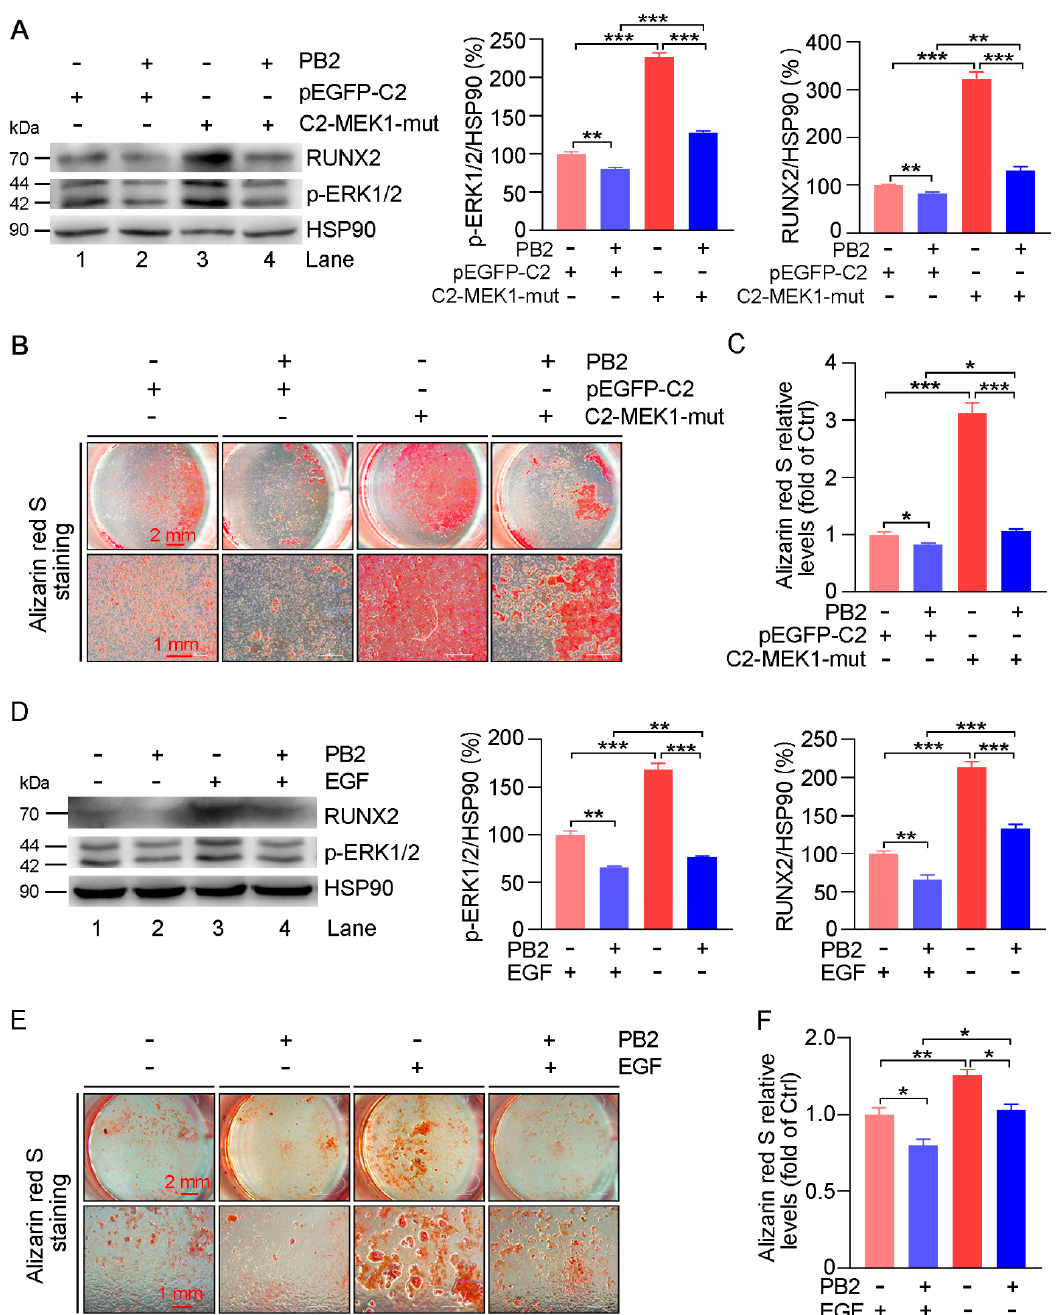
Figure 8. Procyanidin B2 attenuates the activation of ERK1/2 on HASMC calcification. ( A ) HASMCs were transfected with pEGFP-C2 or C2-MEK1-mut for 24 h. The transfected cells had calcification induced in the presence of PB2 (2 µ M) for 7 days. The expression of p-ERK1/2, and RUNX2 protein was determined by Western blot. ** p < 0.01, *** p < 0.001 ( n = 3). HASMCs were transfected with pEGFP-C2 or C2-MEK1-mut for 24 h and then cultured in a CM medium with PB2 (2 µ M) for 2 weeks, followed by alizarin red S staining ( B ) and the quantitative analysis of stained dye ( C ). * p < 0.05, *** p < 0.001 ( n = 3). ( D ) HASMC calcification was induced by CM in the presence of PB2 (2 µ M) for 2 days, and then the cells were treated with EGF (10 ng/mL) for another 5 days. The expression of p-ERK1/2 and RUNX2 protein was determined by Western blot. ** p < 0.01, *** p < 0.001 ( n = 3). HASMCs were cultured in a CM medium containing PB2 (2 µ M) for 1 week, and then they received EGF (10 ng/mL) treatment for another week, followed by alizarin red S staining ( E ) and the quantitative analysis of the stained dye ( F ). * p < 0.05 ( n = 3), ** p <